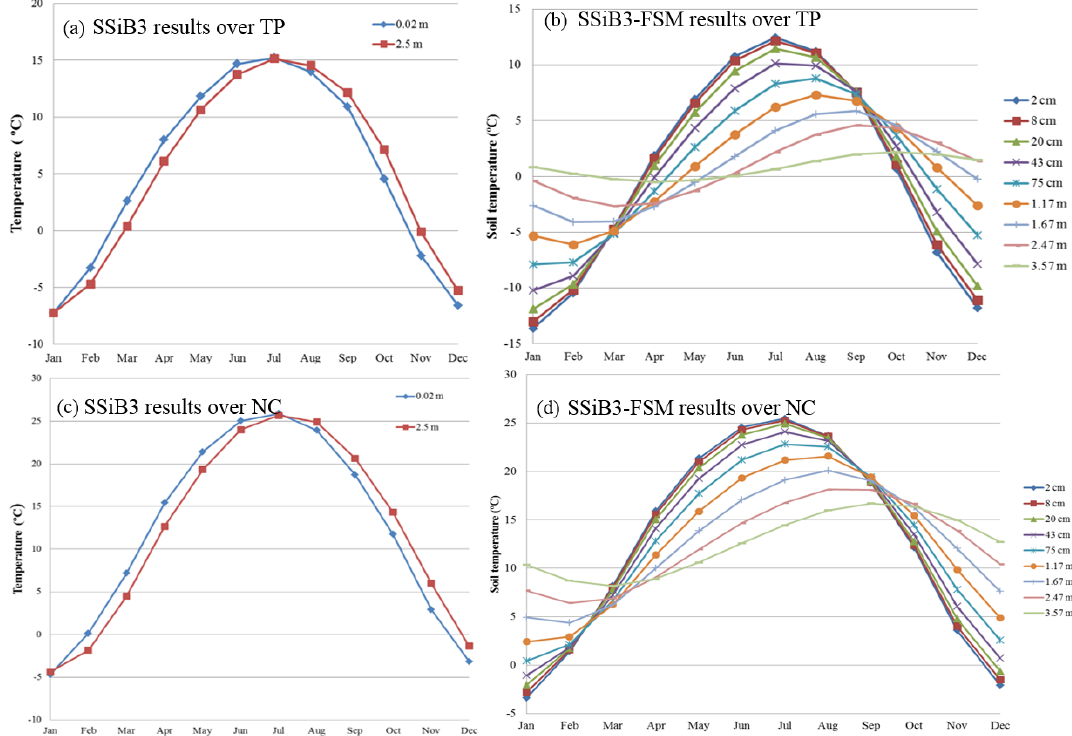
Figure 6. The seasonal soil temperature simulated by SSiB3 and SSiB-FSM over the TP (14 sites) and NC (16 sites) for 1981–2005. (a) The seasonal climatology of T gs (0.02m) and T d (2.5m) by SSiB3 over the TP; (b) the seasonal temperature climatology by SSiB3-FSM over the TP; (c) the seasonal climatology of T gs (0.02m) and T d (2.5m) by SSiB3 over NC, and (d) the seasonal temperature climatology by SSiB3-FSM over NC.